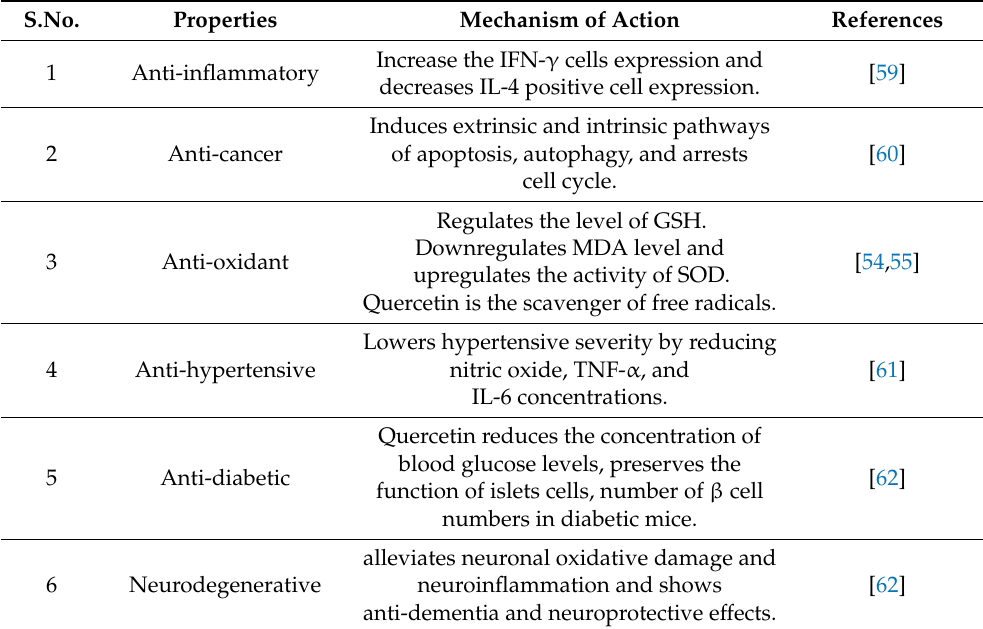
Table 2. The table below highlights the various properties and the mechanism of action of